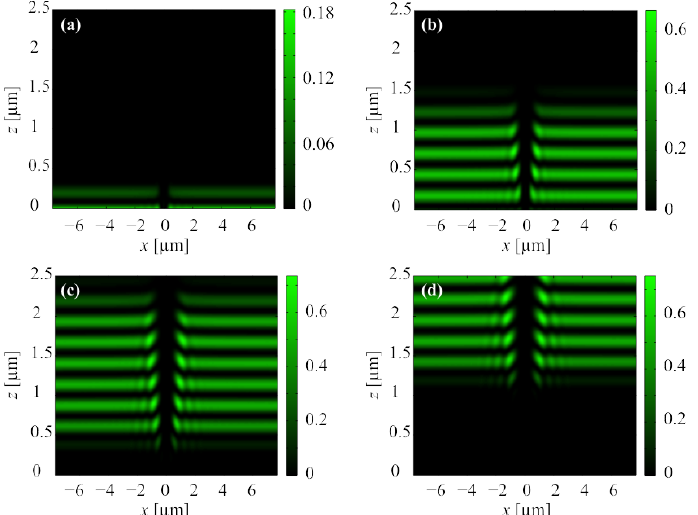
Figure 5. The instantaneous longitudinal pattern of the intensity of the second-order CVB propagating in free space at time of 22.01 fs ( a ),65.05 fs ( b ), 97.06 fs ( c ), and 120.08 fs ( d ).